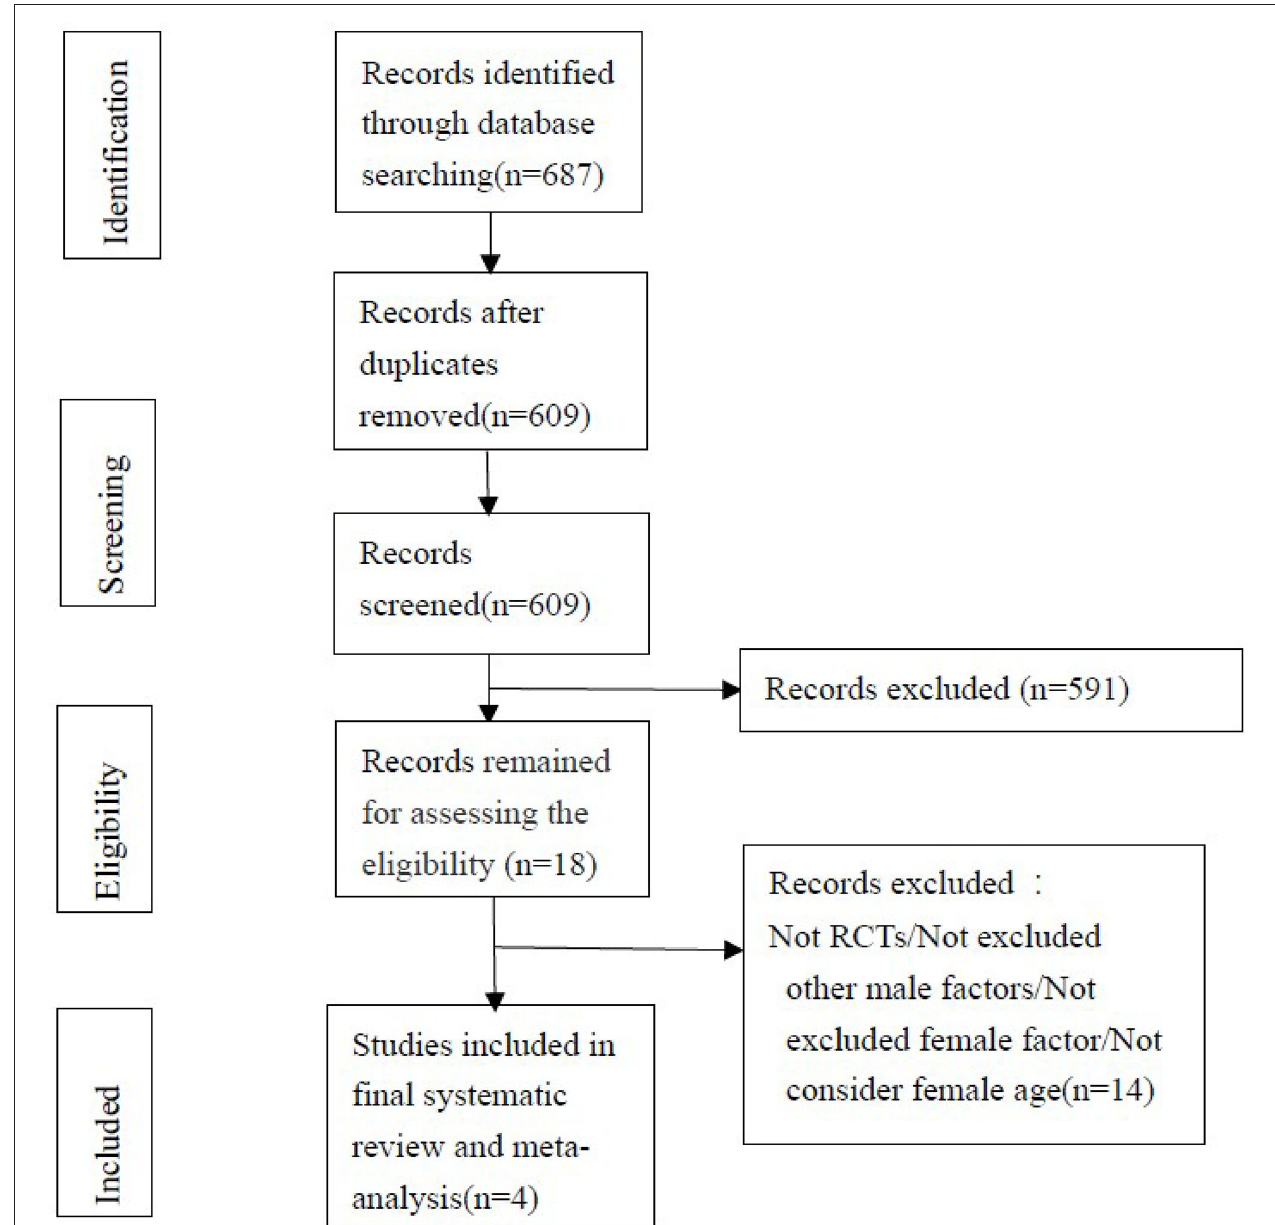
FIGURE 1 | Flow diagram outlining the search strategy and study selection process for this review. RCTs, randomized controlled